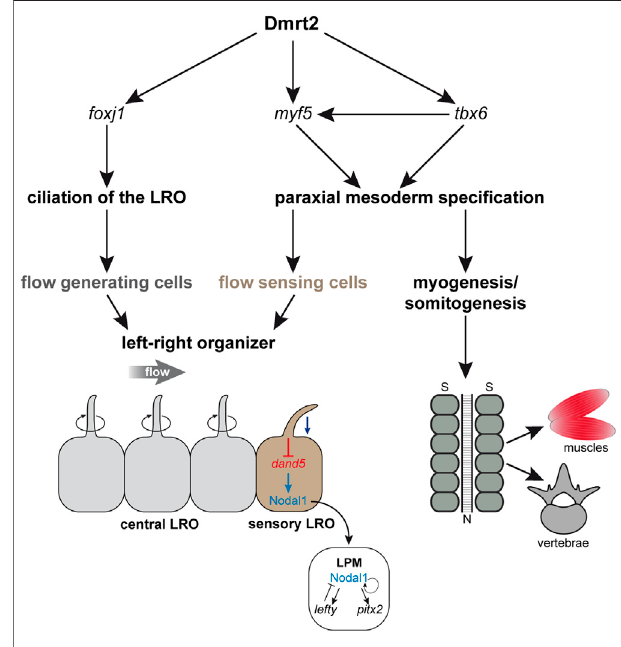
FIGURE 5 | Dmrt2 regulates symmetry breakage and early somitogenesisin Xenopuslaevis .Dmrt2interveneswithtwoprocessesduring symmetrybreakage.Itspeci fi estheLRObyinducing foxj1 intheSMthatgives rise to the ciliated epithelium, which generates a leftward fl ow of extracellular fl uid (left panel). Simultaneously, Dmrt2 activates tbx6 and myf5 expression in the early gastrula embryo, leading to the speci fi cation of the paraxial mesoderm (right panel), which later differentiates into muscles and vertebrae. In addition, the somatic functions of Dmrt2 and Myf5 are required for sensory LRO morphogenesis and thus for Nodal-cascade induction in the left LPM. N = notochord; S =